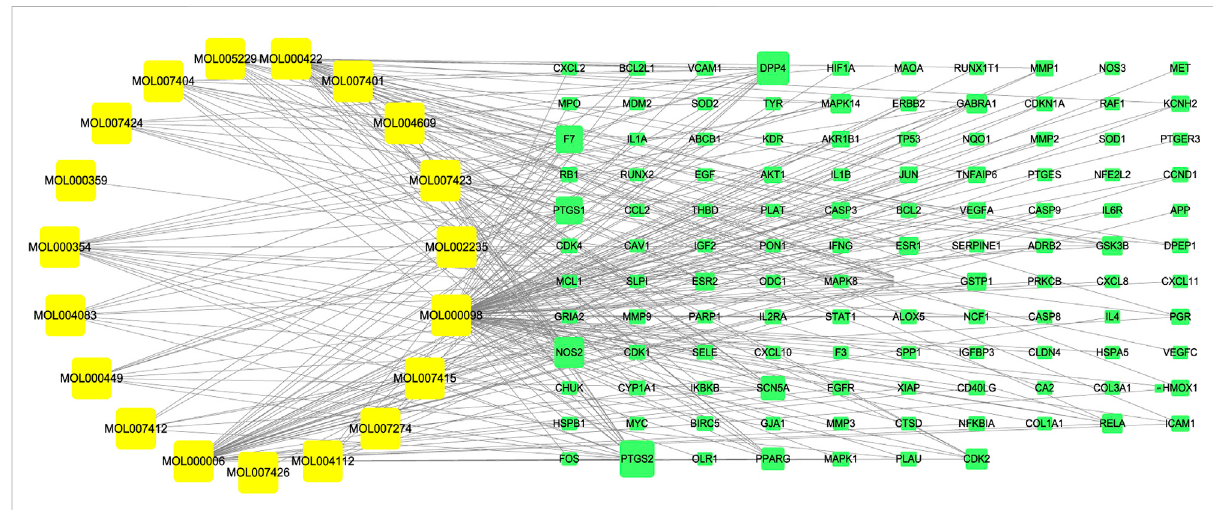
FIGURE 5 “ Component-target ” network diagram. Yellow represented the active components of A. annua in the treatment of AAA, and green represented the potential